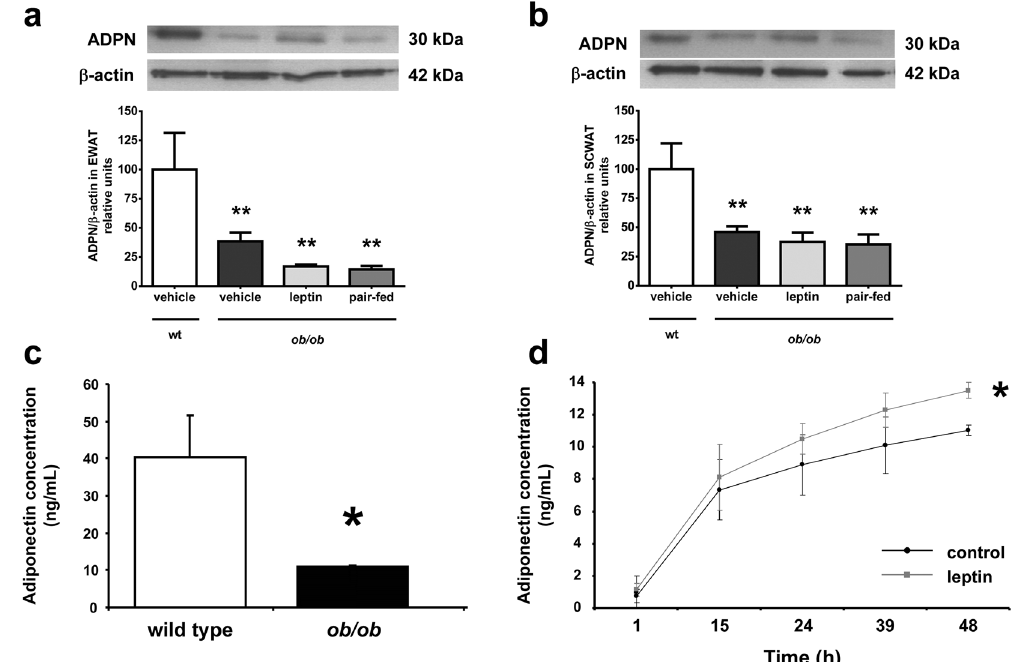
Figure 2. Protein amount of adiponectin is decreased in white adipose tissue of ob/ob mice and leptin stimulates its secretion from adipocytes. Protein expression levels of total adiponectin (ADPN) in mouse epididymal (EWAT, a ) and subcutaneous (SCWAT, b ) adipose tissues from wild type (wt) and ob/ob mice receiving vehicle, leptin or receiving vehicle and pair-fed to the leptin group. The blot densitometry data were normalized with β -actin values (upper panels). Values are the mean ± SEM. The expression of ADPN in the wt group was assumed to be 100. Differences between groups were analyzed by ANOVA followed by LSD